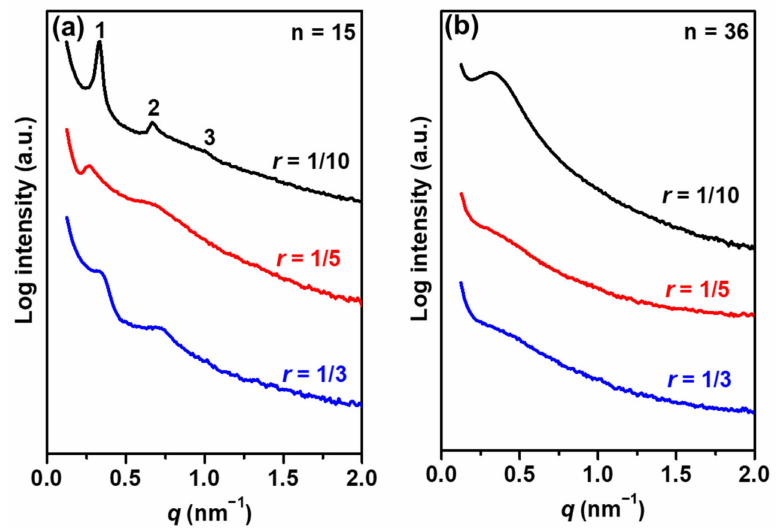
Figure 2. SAXS profiles of the PEO 114 - b -PDM n -dTFSI/LiTFSI electrolytes with different doping ratios at 30 ◦ C when ( a ) n =15 and ( b )